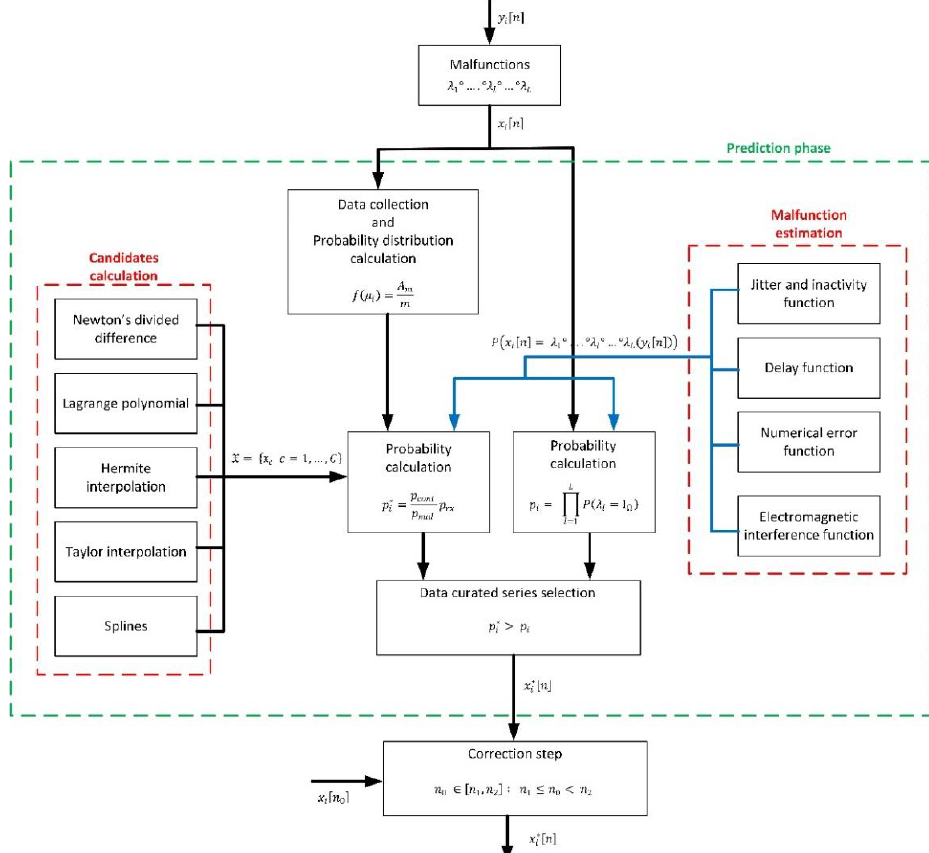
Figure 1. Global overview of the proposed prediction-correction algorithm. As can be seen (in the initial prediction phase), first, a set of C suitable candidates X to [ n ] are calculated be that curated time series x ∗ i